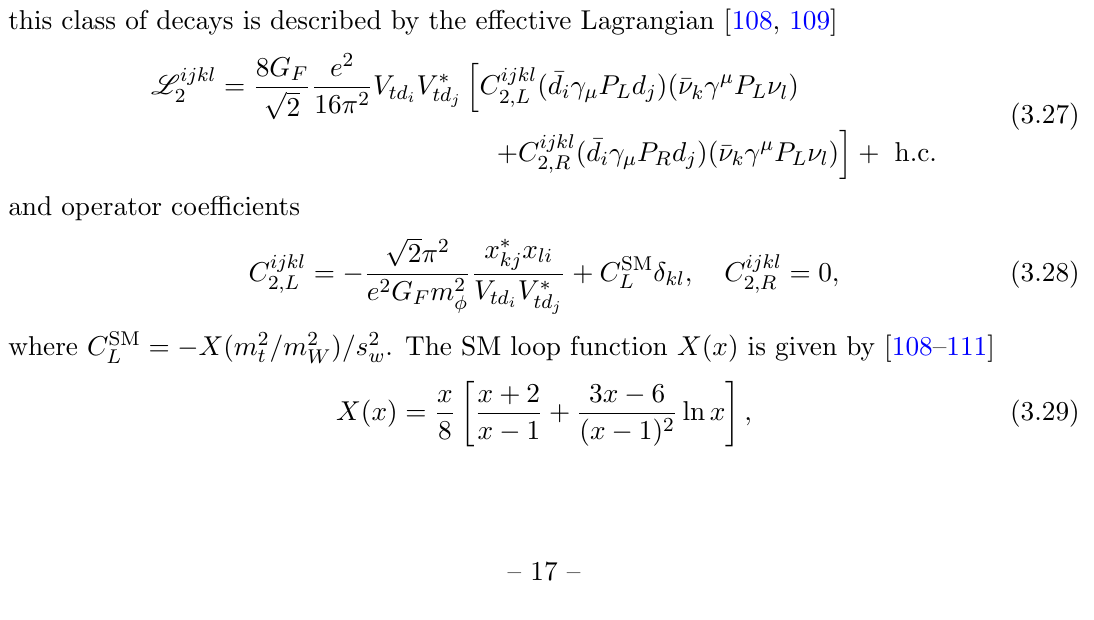
Figure 7. The branching ratio Br( B and new physics in both C (dashed orange). The 30% limit is shown in red (dot-dashed). The dark and light grey regions represent the 1 and 2 (cid:27) regions for R in the region of